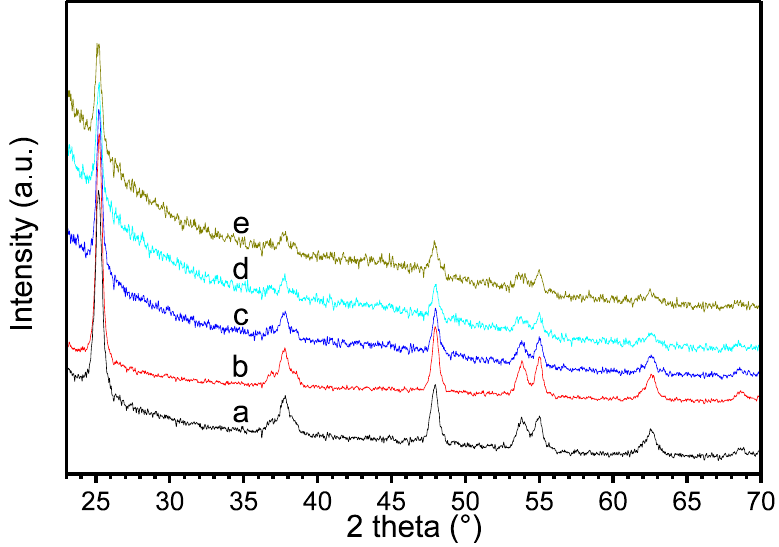
Figure 2. XRD patterns of pristine TiO 2 ( a ), TiO 2−δ ( b ), CNT-TiO 2−δ -5 ( c ), CNT-TiO 2−δ -15 ( d ) and CNT-TiO 2−δ -60 ( e